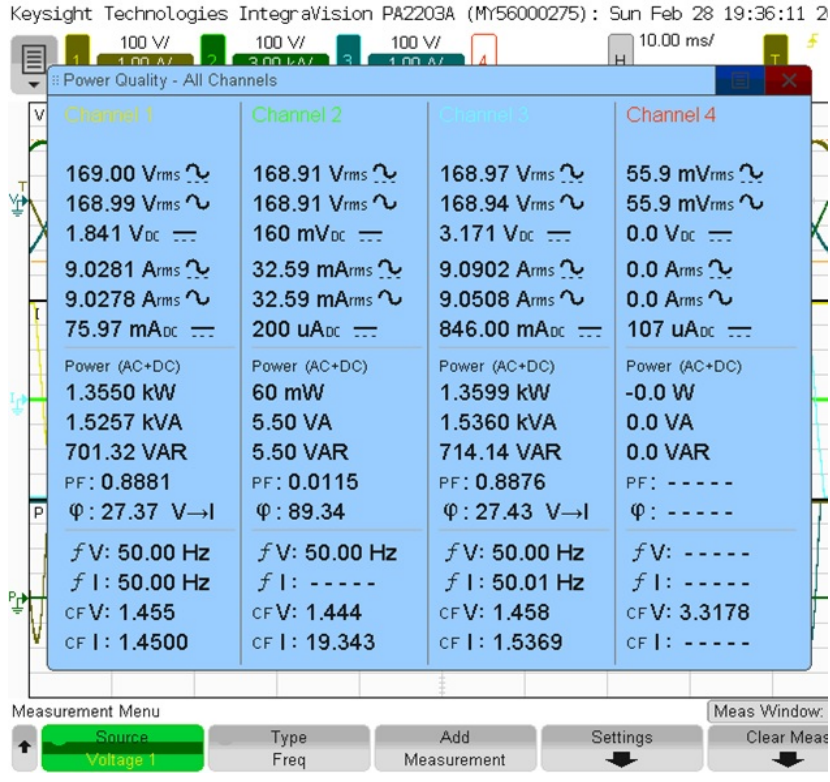
Figure 12. Voltage sag conditions in grid connected to induction motor under loaded conditions.